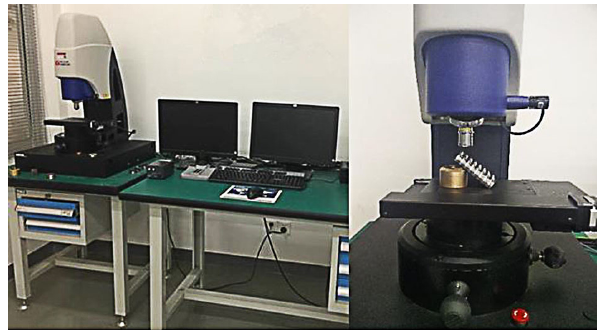
Figure 8. The Taylor Hobson CCI(UK) white light